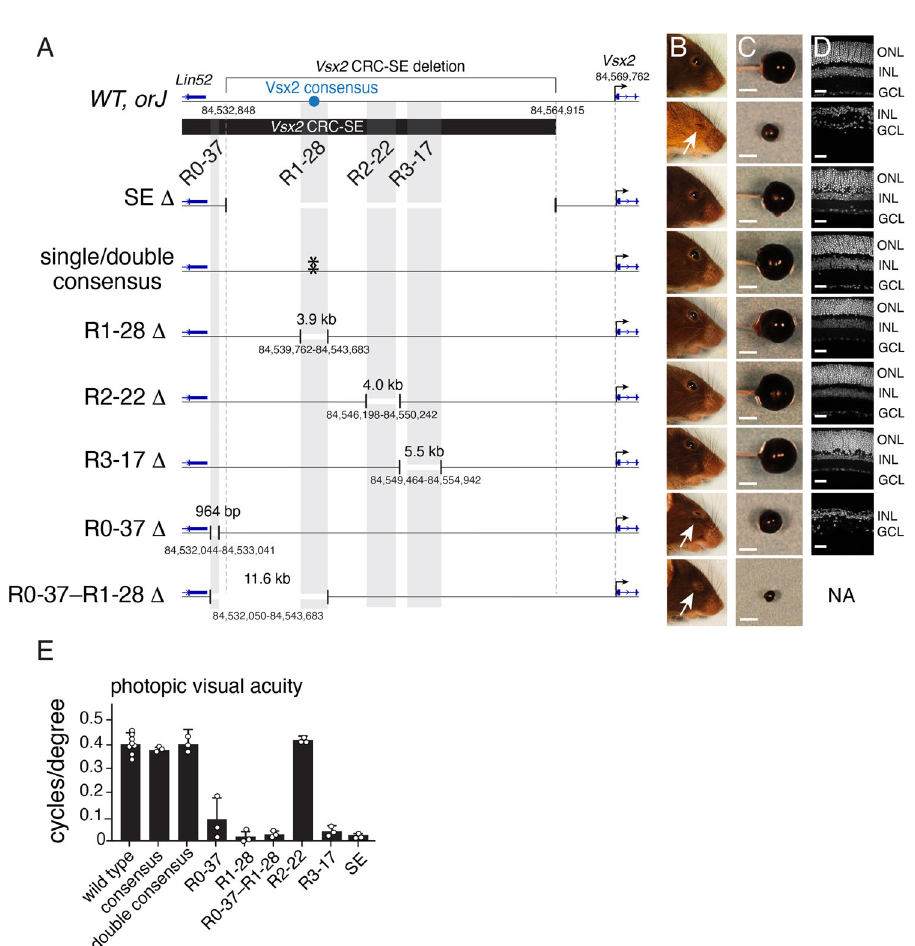
Fig. 5 Analysis of mouse strains with deletions of evolutionarily conserved domains of the Vsx2 SE. A Drawing of the eight strains with deletions made using CRISPR-Cas9. There were three separate lines used for the consensus that had each site mutated individually and the combination of the two sites mutated. B Photograph of adult mice with each homozygous deletion and the orJ mouse strain as a reference for microphthalmia. C Photograph of eyes for each strain showing microphthalmia for the orJ , R0-37, and R0-37 – R1-28 strains. D DAPI stained micrographs of retina from each strain. E Bar plot of mean with SEM of photopic vision (cycles/degree). n = 3 biologically independent mice for each deletion mouse strain. n = 8 biologically independent animals for wild-type mice. Abbreviations: ONL, outer nuclear layer; INL, inner nuclear layer; GCL, ganglion cell layer; Scale bars: 2.5 mm. Source data are provided as a Source Data fi